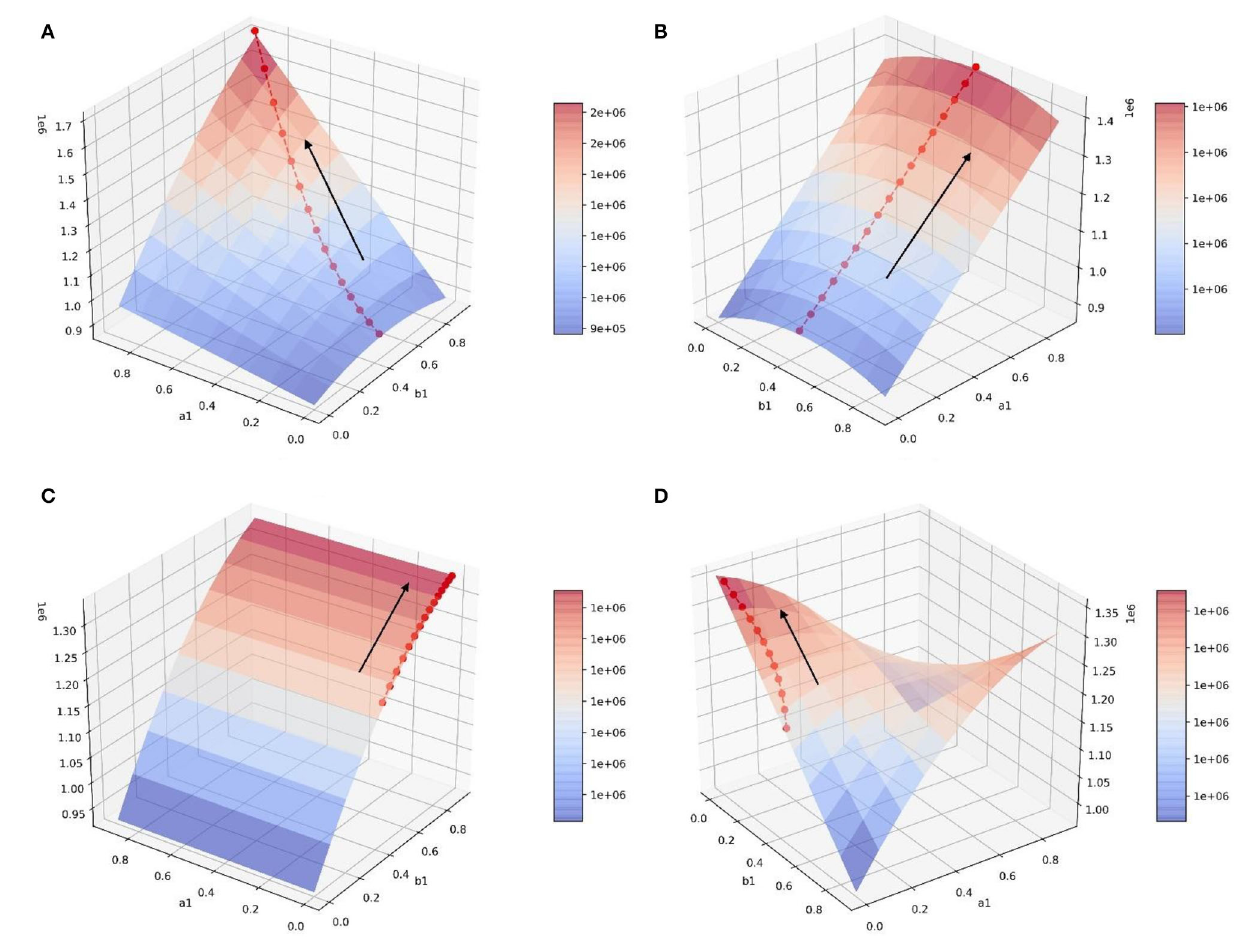
FIGURE 16 | Optimal policy paths in four scenarios. (A) Optimal policy path in scenario 1. (B) Optimal policy path in scenario 2. (C) Optimal policy path in scenario 3. (D) Optimal policy path in scenario